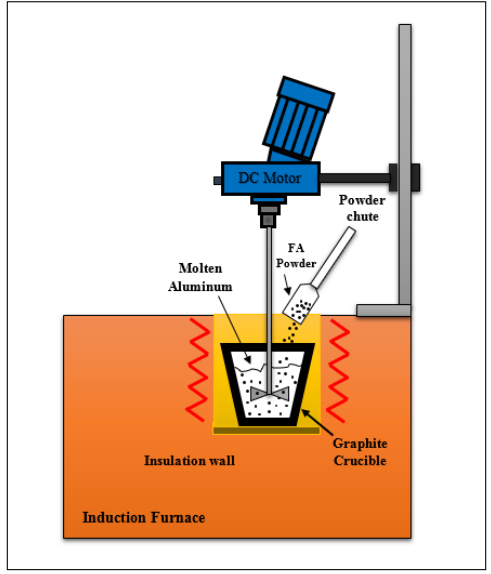
Figure 1. Schematic diagram of casting technique (DC: Direct current; FA: Fly ash).